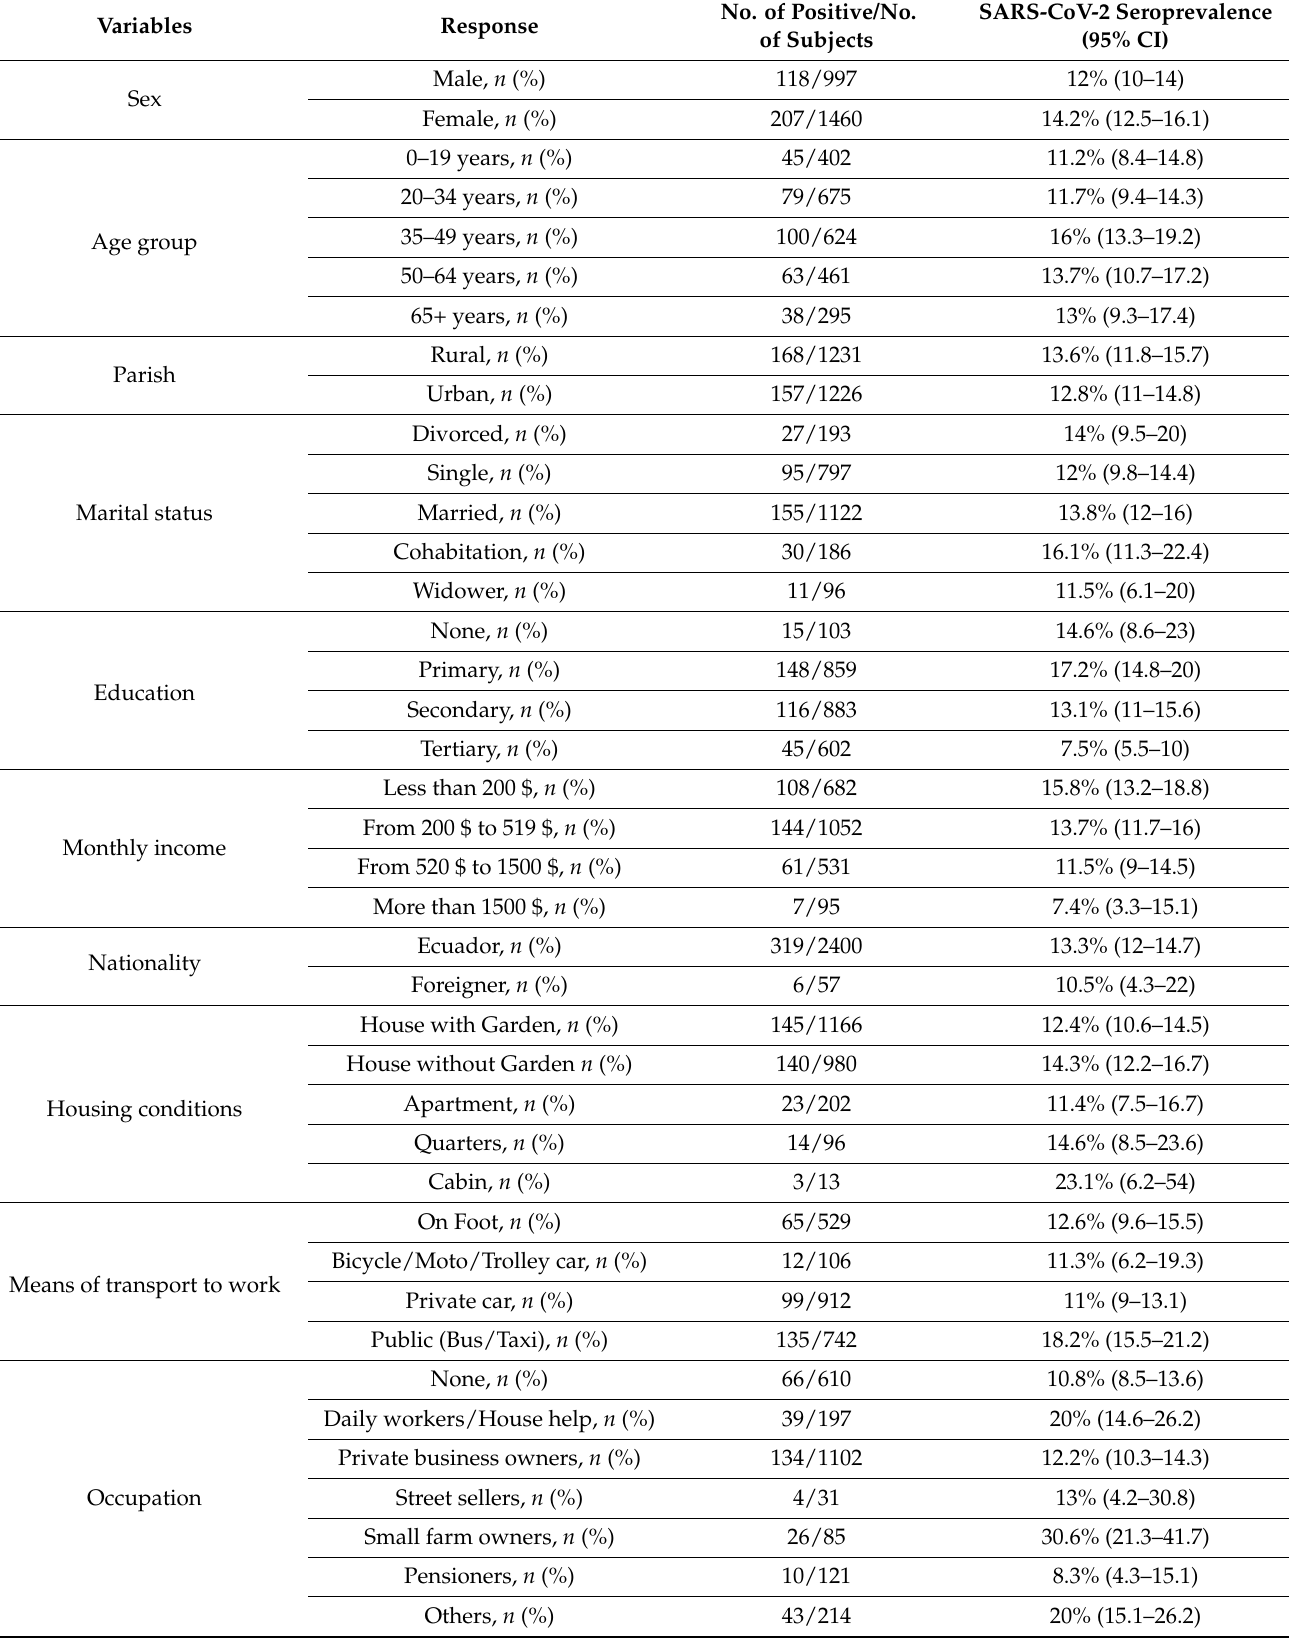
Table 2. SARS-CoV-2 seroprevalence by general characteristics of the